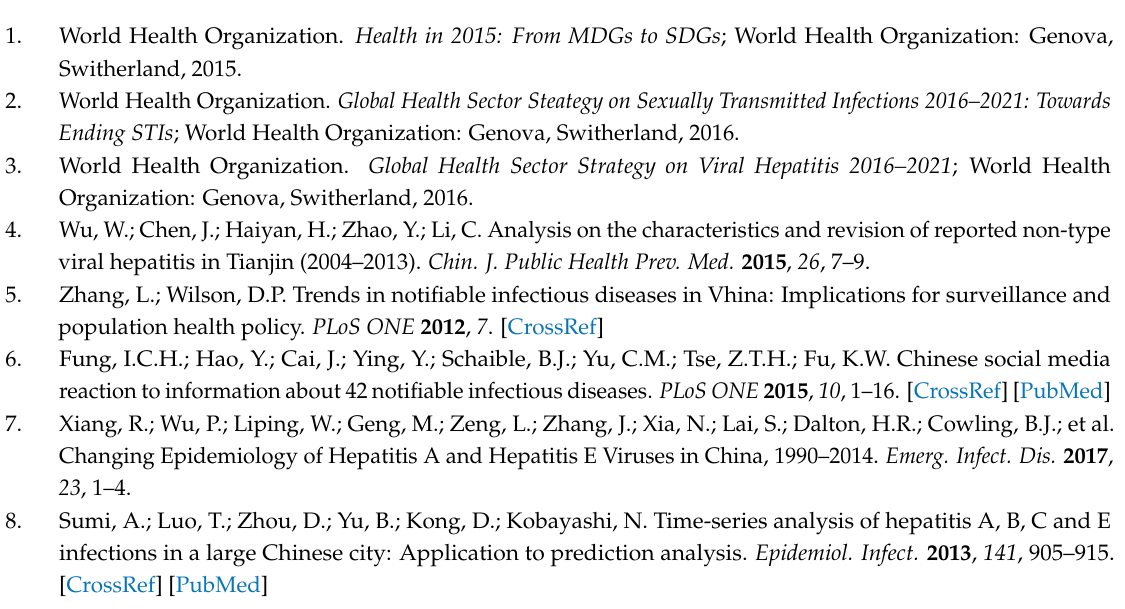
Table S1. The incidence of hepatitis A, B, C, E and unspecified in each provincial unit from 2003 to 2015. Table S2. The population in each provincial unit from 2003 to 2015. Table S3. The formulas of and detailed explanations for Global and Local Moran’s I. Table S4. The chi-square and p -value results for linear by linear association test. Author Contributions: Bin Zhu and Ying Mao conceived and designed the study; Bin Zhu collected and analyzed the data; Bin Zhu, Jinlin Liu and Yang Fu drafted the paper, Bo Zhang and Ying Mao read and revised the draft critically. All authors read and approved the final